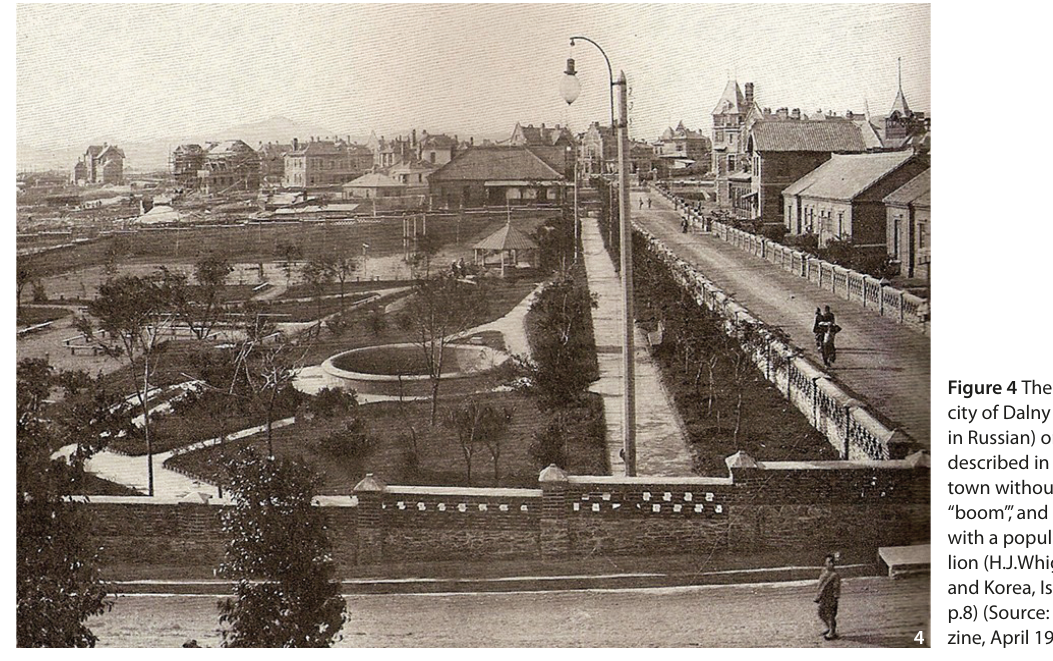
Figure 4 The new Russian port city of Dalny (meaning ‘far place’ in Russian) on the Chinese coast, described in 1904 as ‘A “boom” town without any reason for a “boom”,’ and a century later a city with a population of over 6 mil- lion (H.J.Whigham, Manchuria and Korea, Isbister & Co., 1904, p.8) (Source: Scribner’s Maga- zine, April 1903).